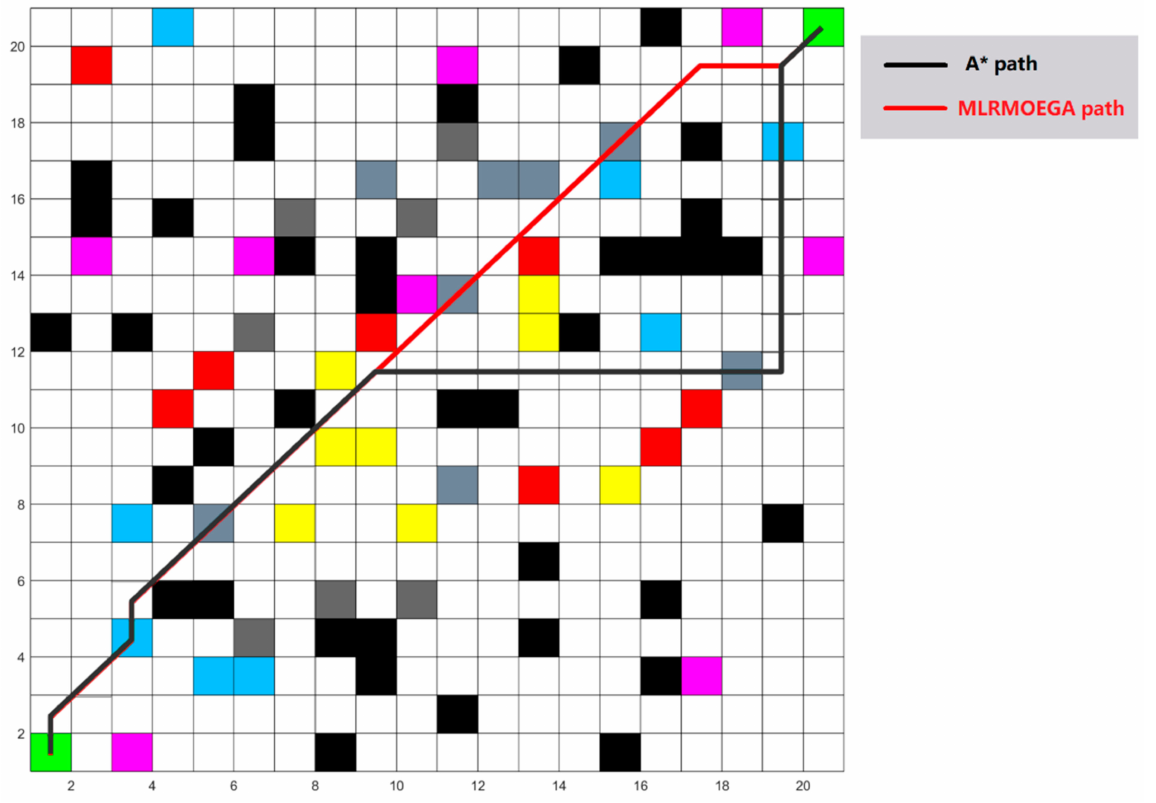
Figure 18. The test 20 × 20 grid map and